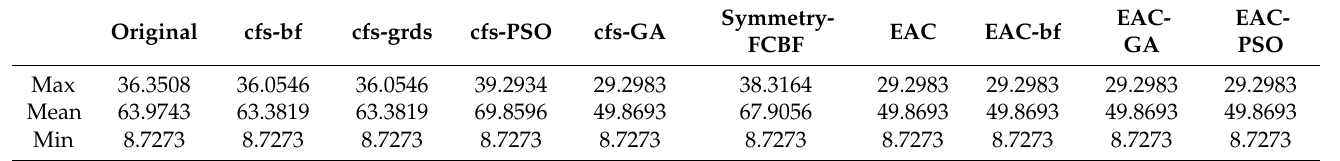
Table 2. Kappa of the Hoeffding tree model coupled with ten preprocessing algorithms.